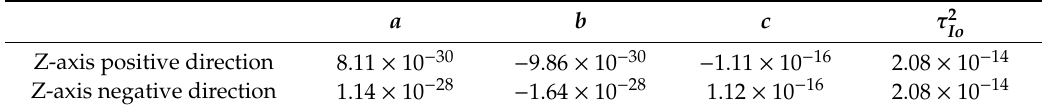
Table 1. Cubic polynomial coe ffi cients of fitting Z P and τ IZ .